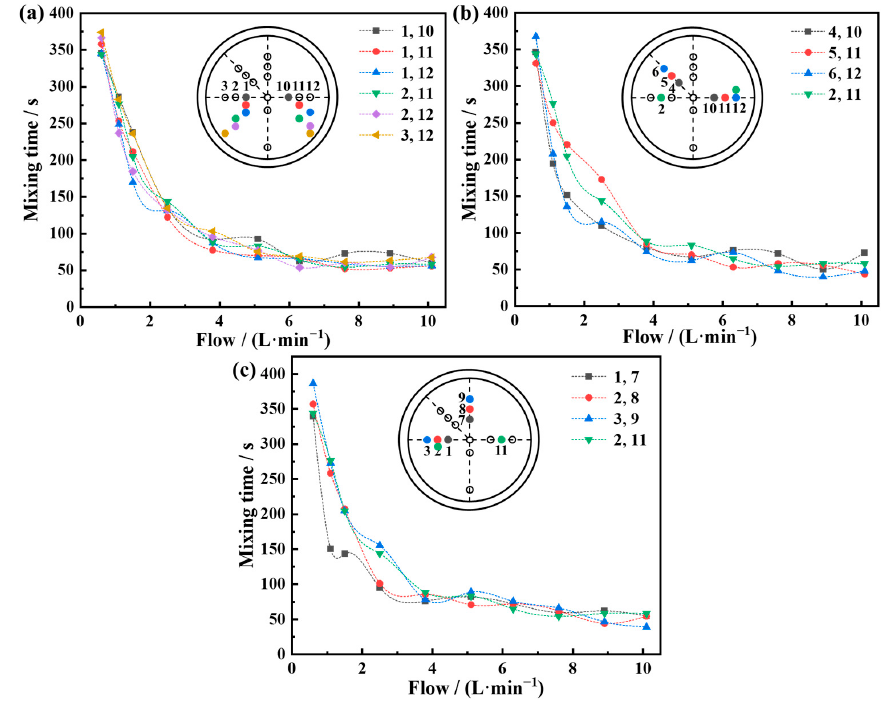
Figure 8. Mixing time of different blowing volumes in the double hole ( a ) 180°, ( b ) 135°, ( c ) 90° distribution schemes. distribution schemes.